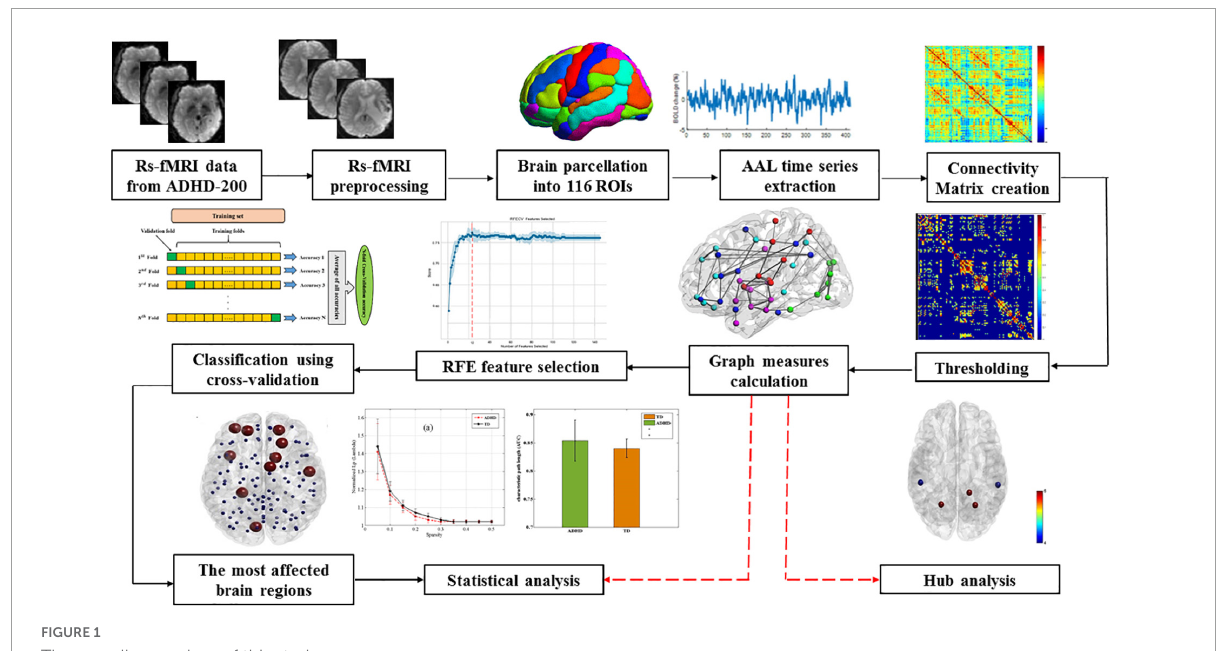
FIGURE1 The overall procedure of this